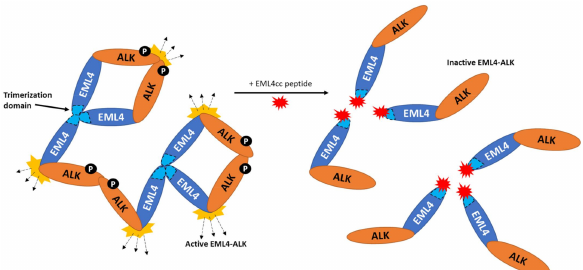
Figure 3. Blocking EML4-ALK trimerization. The illustration on the left shows how oligomerization via the trimerization domain of EML4 (dotted areas, coloured light blue) and the phosphorylation (P) of the ALK tyrosine kinase domain leads to ALK activation and downstream signalling. On the right, a synthetic peptide (EML4cc) analogous to the trimerization domain coiled-coil sequence (red star) blocks EML4-ALK trimerization through competitive TD binding and is shown to prevent activation of